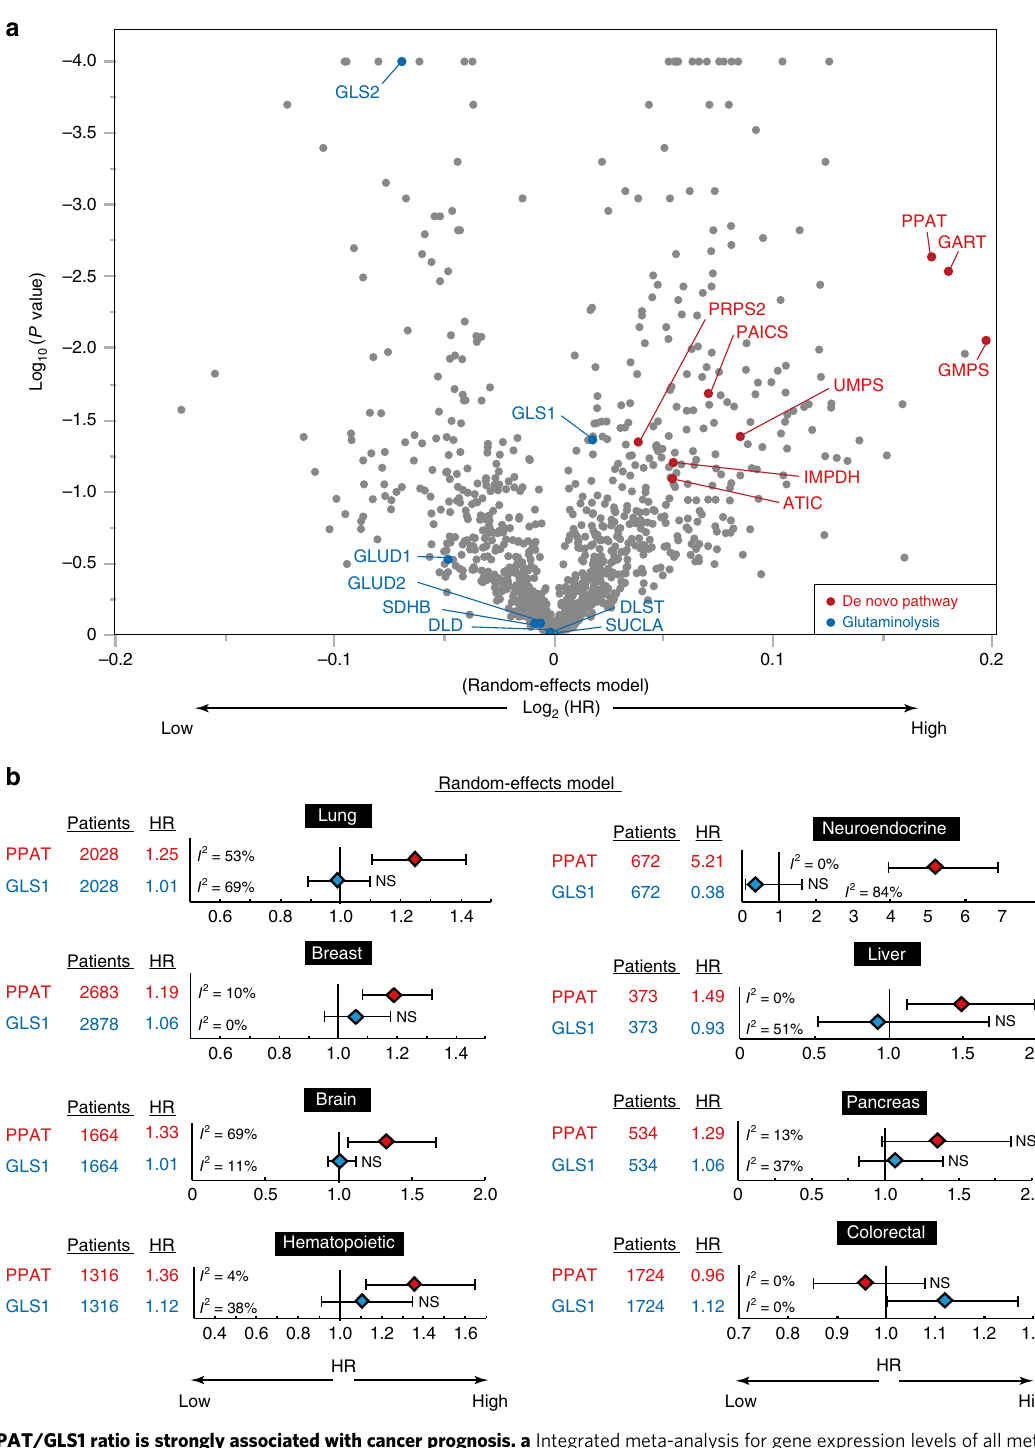
Fig. 6 The PPAT/GLS1 ratio is strongly associated with cancer prognosis. a Integrated meta-analysis for gene expression levels of all metabolic enzymes (1126 enzymes) in cancer cohort studies combined by means of the random-effects model. Enzymes of the de novo nucleotide biosynthetic pathway and the glutaminolysis pathway are shown in red and blue, respectively. The integrated hazard ratios (HRs) and P -values are shown in a volcano plot. The total numbers of patients were as follows: PPAT, 10,994; PRPS2, 11,401; GART, 12,135; PAICS, 11,286; ATIC, 11,146; IMPDH, 11,345; GMPS, 11,705; UMPS, 11,543; GLS1, 11,819; GLS2, 10,338; GLUD1, 10,898; GLUD2, 10,735; DLST, 11,217; DLD, 11,974; SUCLA, 10,865; and SDHB, 11,694. b Cancer cohort studies for each organ were combined by means of the random-effects model. The integrated HR and its 95% con fi dence interval, the numbers of patients, and the heterogeneity score ( I 2 ) are shown. The centre of effect sizes (HR = 1.0) are shown as vertical line in b . NS not signi fi cant. All cohorts were divided at the median gene expression level in both a , b . Source data are provided as a Source Data fi